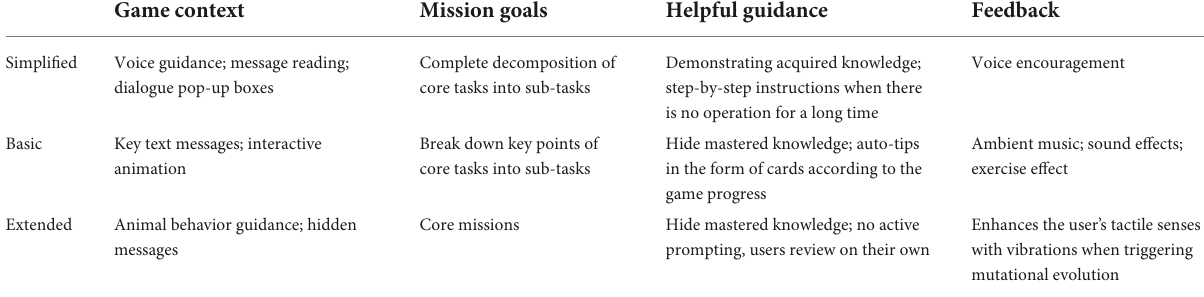
TABLE 1 Game function